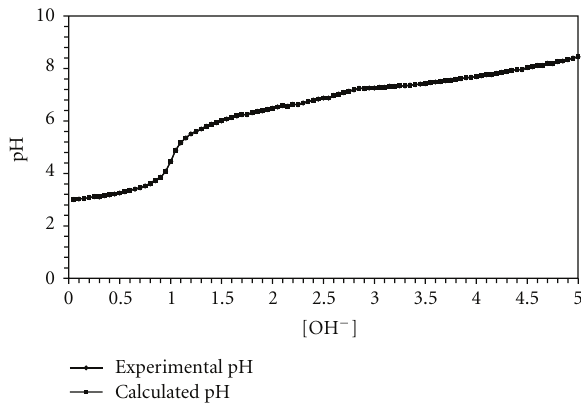
Figure 6: Experimental and calculated potentiometric titration curves of the Zn II -BAPP-Threonine system.